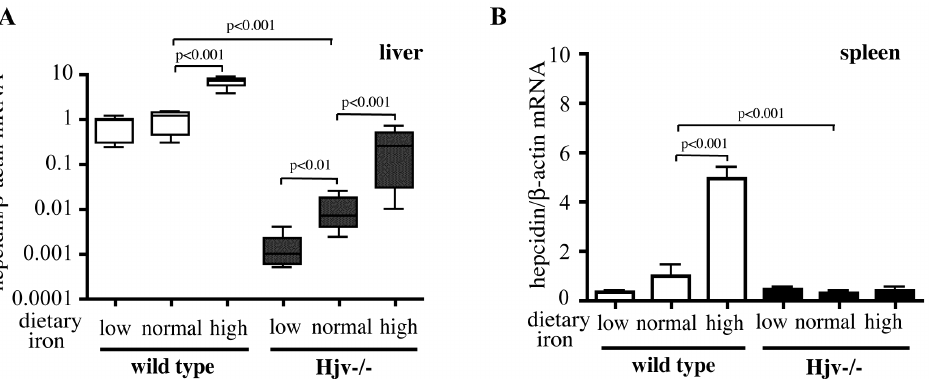
Figure 3. Residual iron-dependent regulation of hepatic hepcidin mRNA expression in Hjv 2 / 2 mice. RNA was extracted from tissues of the Hjv 2 / 2 and wild type mice described in Fig. 1 and used for qPCR analysis. (A) Expression of hepatic hepcidin mRNA. (B) Expression of splenic hepcidin mRNA. Note that absolute hepcidin mRNA levels in the spleen are . 100 times lower than in the liver. Data are presented as the mean 6 SEM. The p values were calculated by using one-way ANOVA with Bonferroni post-test correction. Detailed statistical analysis is provided in Table S1.